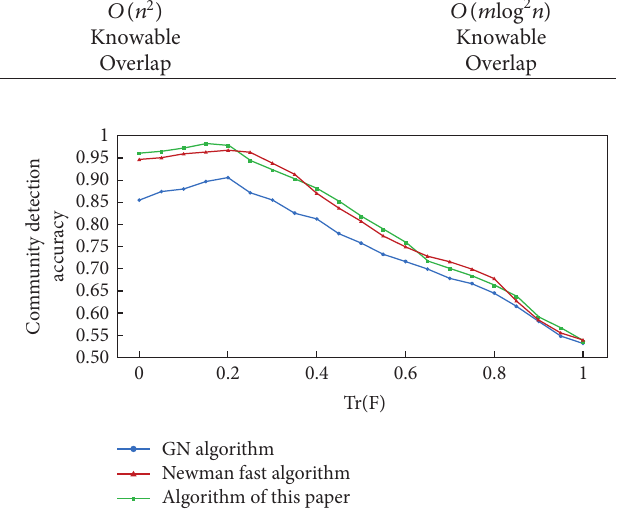
Figure 9: Algorithm performance comparison